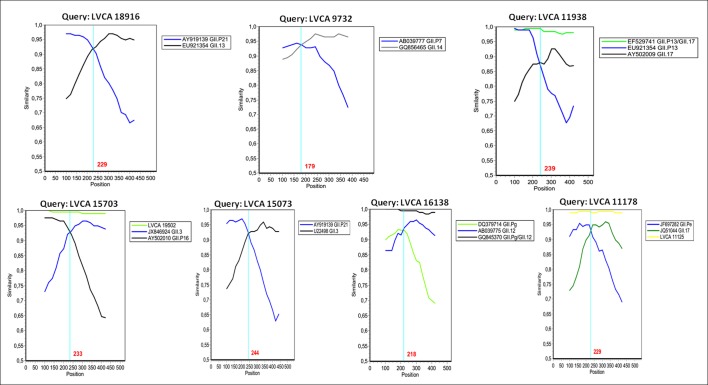
Similarity plots of the NoV recombinant types detected in Southern Brazil during the 2004–2011 period.SimPlot was constructed using Simplot version 3.5.1 with a slide window width of 200 bp and a step size of 20 bp. The vertical axis indicates nucleotide identities (%) between the query sequences (Brazilian samples) and the reference strains. NoV parental strains are indicated by the accession numbers and their respectively ORF1-based genotypes (indicated by the letter P) or ORF2-based genotypes.